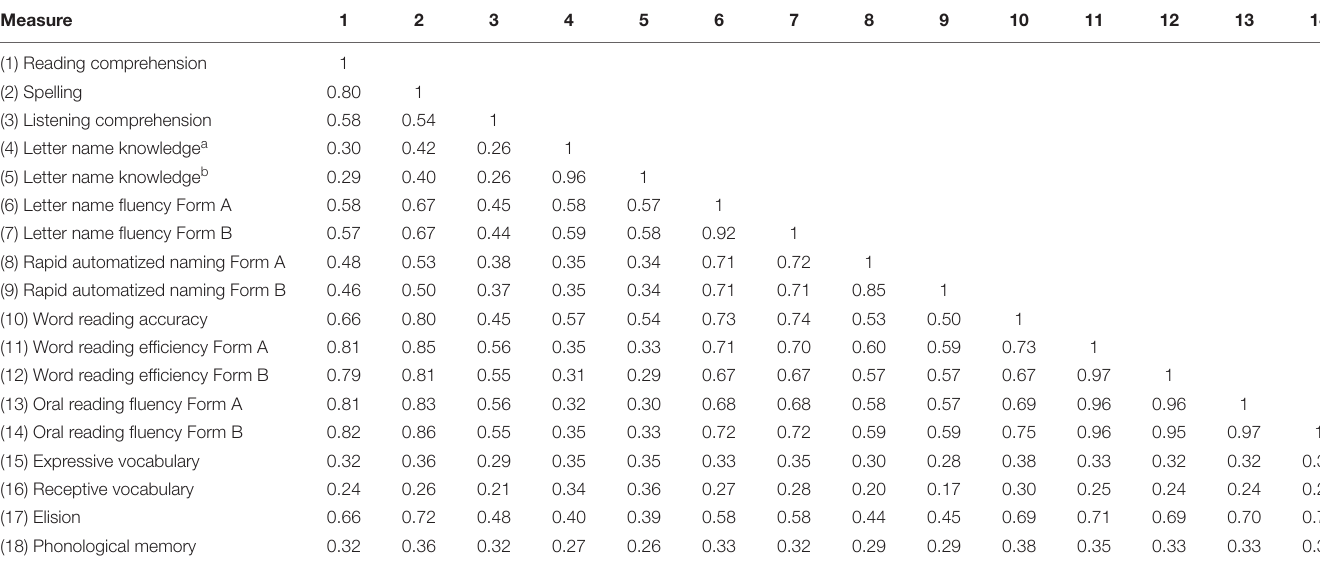
TABLE 2 | Intercorrelations between the assessment measures.